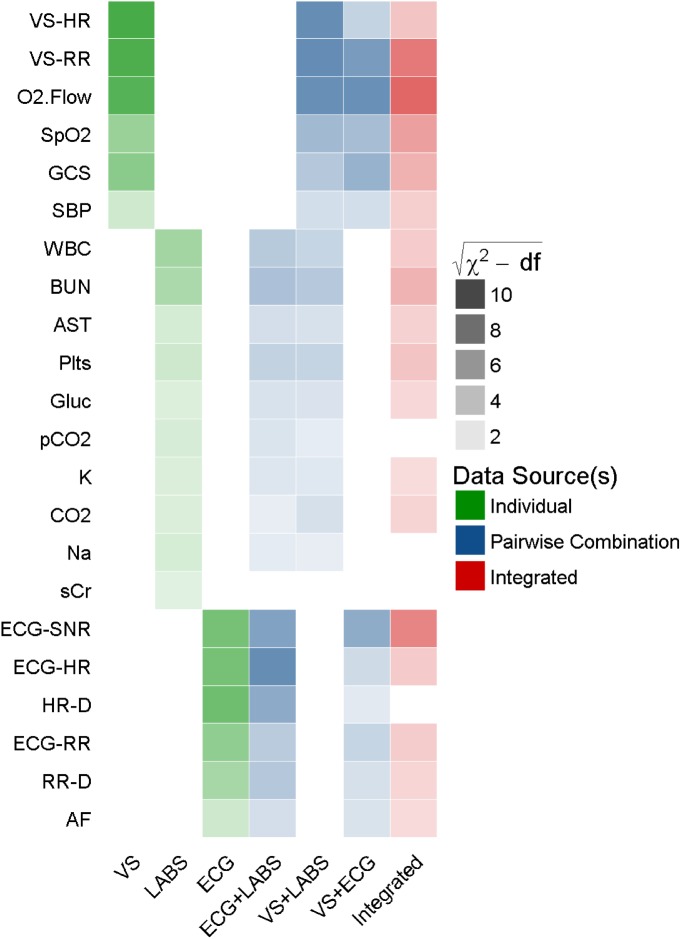
Relative statistical significance of component predictors included.Heatmap depiction of statistical significance of predictors (rows) in each model (columns) with corresponding C-statistics. Saturation or transparency depicts the statistical significance as calculated by the square root of (χ2 minus degrees of freedom (df)) and can be likened to the absolute value of a Z score adjusted for the degrees of freedom associated with a predictor due to higher order terms. Hue or color represents the data source: individual data sources (green), pairwise combinations (blue), fully integrated model using all available data (red). Predictors that failed to achieve statistical significance in any of the models are not displayed. VS-HR: charted heart rate, VS-RR: charted respiratory rate, O2.Flow: charted oxygen flow rate, SpO2: charted oxygen saturation, GCS: Glasgow Coma Scale, SBP: systolic blood pressure, WBC: white blood cell count, BUN: blood urea nitrogen, AST: aspartate aminotransferase, Plts: platelets, CO2: carbon dioxide, Glu: glucose, pCO2: partial pressure of carbon dioxide, K: potassium, Na: sodium, sCr: creatinine, ECG-SNR: Signal-to-Noise metric from ECG-derived respirations, ECG-HR: heart rate from continuous ECG, HR-D: trend of HR over prior 24 hours, ECG-RR: ECG-derived respiratory rate, RR-D: trend of RR over prior 24 hours, AF: atrial fibrillation, EMR: electronic medical record.